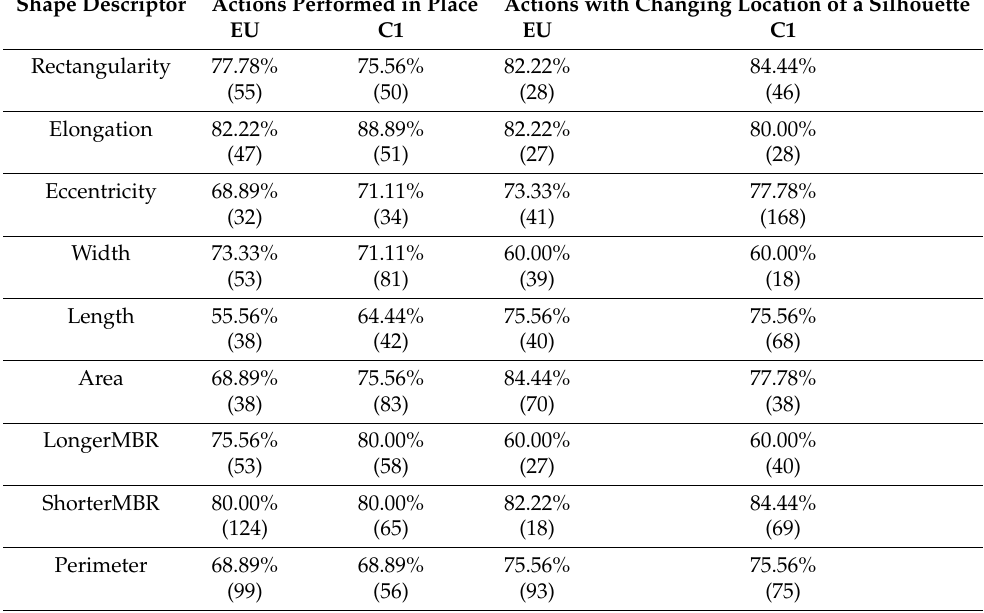
Table 2. Results for the experiments using the ‘upper-occlusion’ database. Correct classification rates are given for coarsely classified actions, nine shape descriptors based on the Minimum Bounding Rectangle and two matching measures (EU—distance, C1—correlation). The number of the DFT coefficients is given in